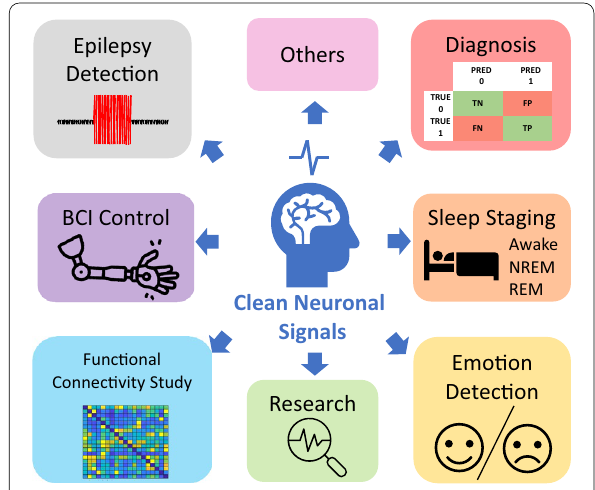
Fig. 1 Overview of the application areas that benefit from the removal of